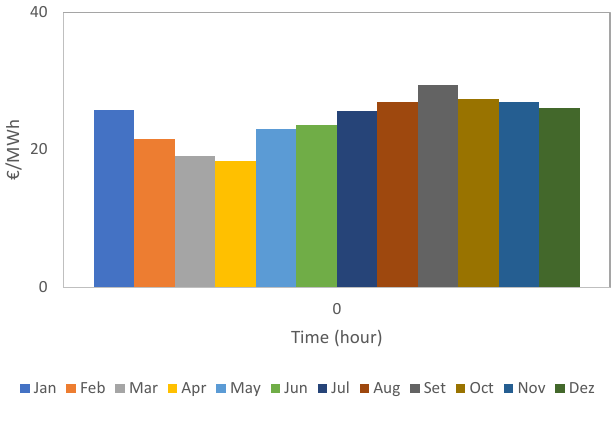
Figure A5. Average gas prices, per month.